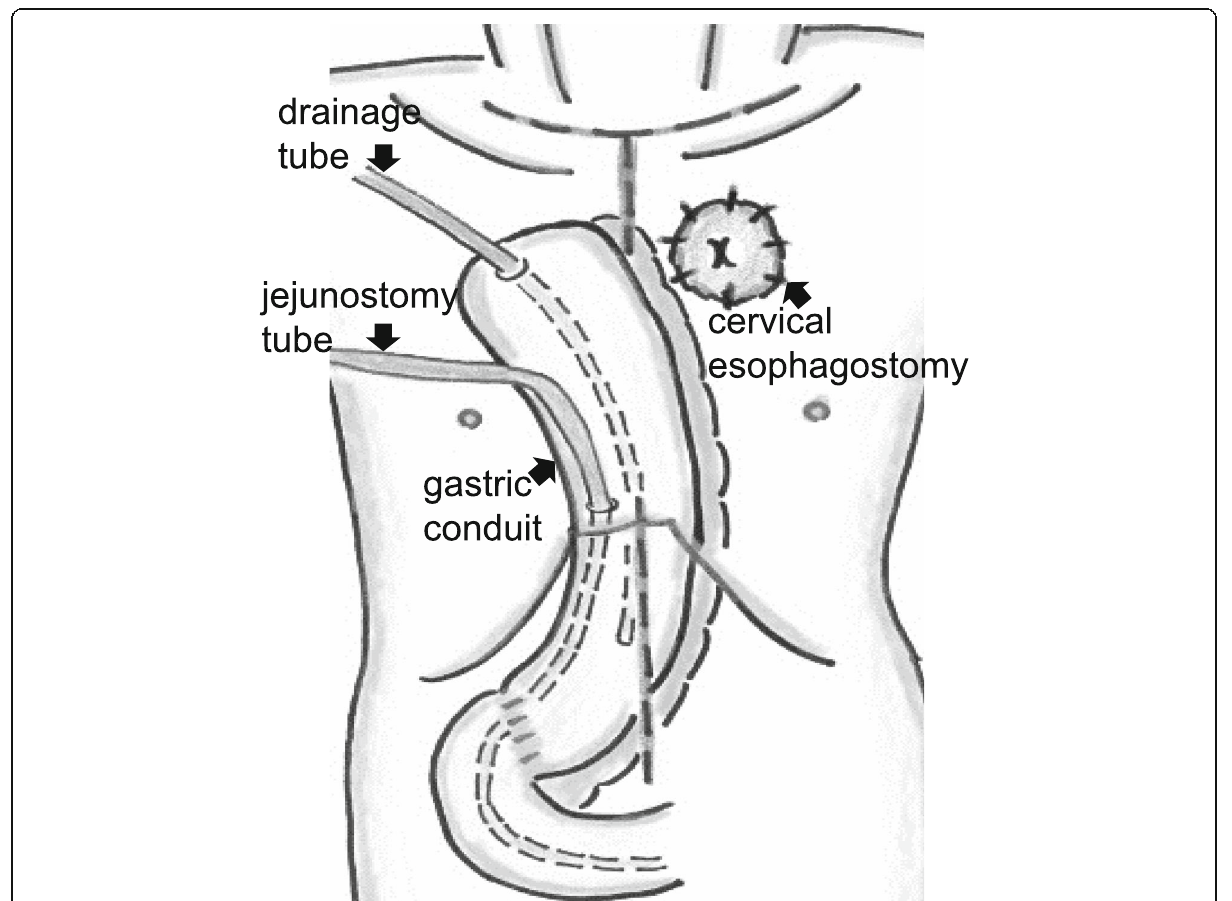
Fig. 5 Postoperative schema. The gastric conduit is pulled up and through the subcutaneous route, followed by creation of cervical esophagostomy. A gastrostomy tube for drainage and a jejunostomy tube for postoperative enteral nutrition are placed on the subcutaneous gastric